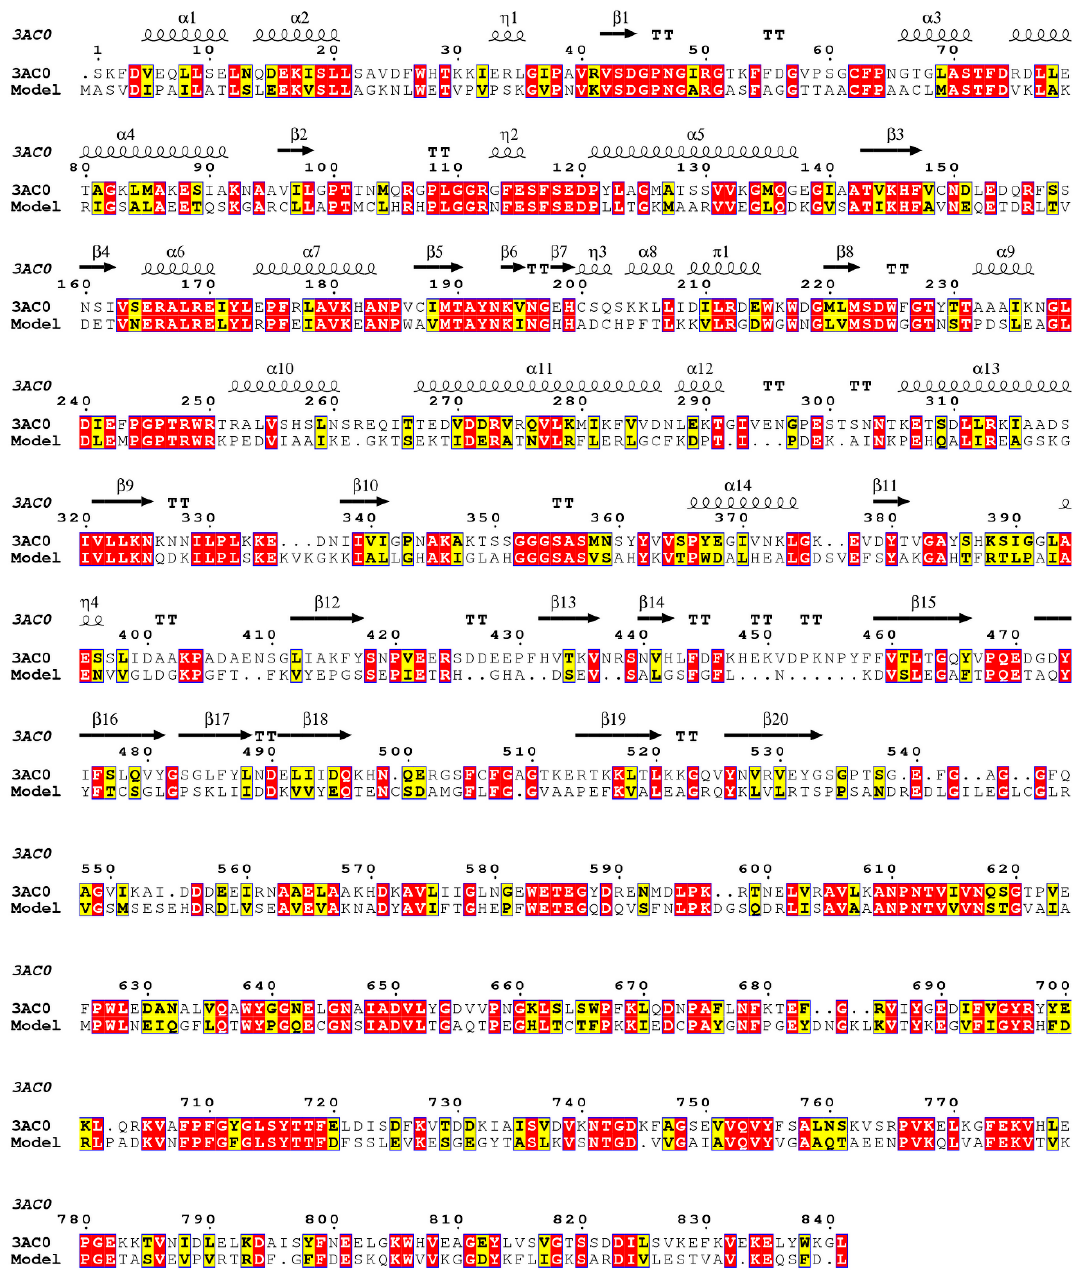
Figure 2. Primary sequential alignment for template (3AC0) and the target (Model): red for identical residues and yellow for similar